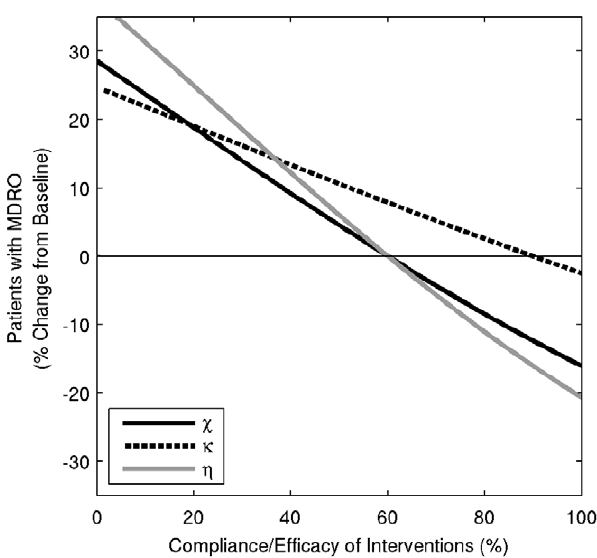
Figure 3. The percentage change from baseline of patients that are colonized with an MDRO at one year. Grey line - hand hygiene measure compliance is varied; solid black line - the percentage of compliance with contact precautions is varied; dashed line - the efficacy of screening patients receiving antibiotics is varied.